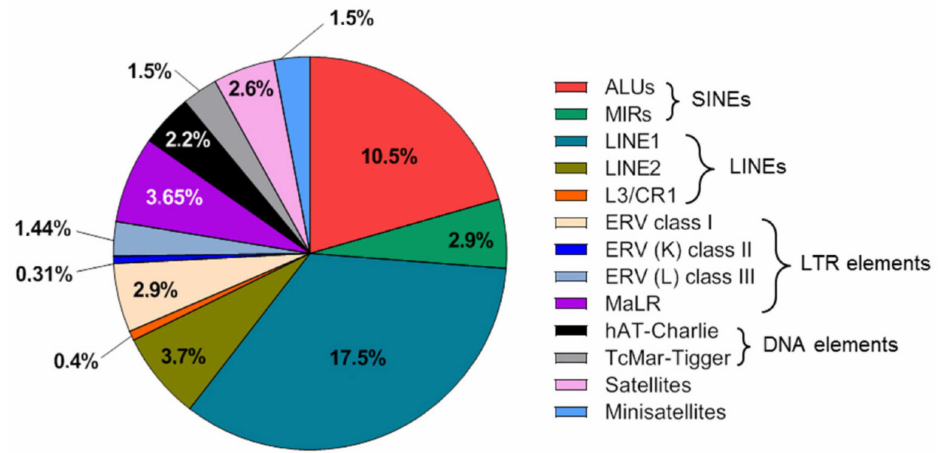
Figure 1. Distribution of the major repetitive element families in the human genome. The repetitive element landscape is vulnerable to numerous cancer-specific modifications. The abundance of repetitive DNA in the human genome and its widespread occurrence across all chromosomes, is mirrored in the cfDNA content of clinical biospecimens, which makes the characterization of repetitive cfDNA an attractive liquid biopsy tool for interrogating various cancer